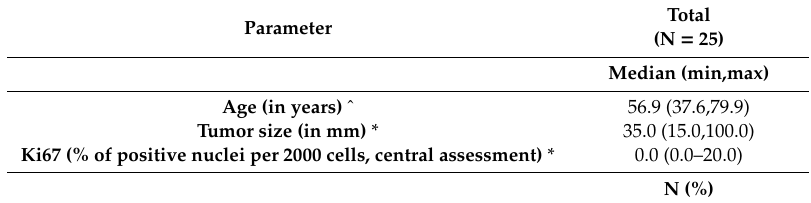
Table 1. Selected patient and tumor